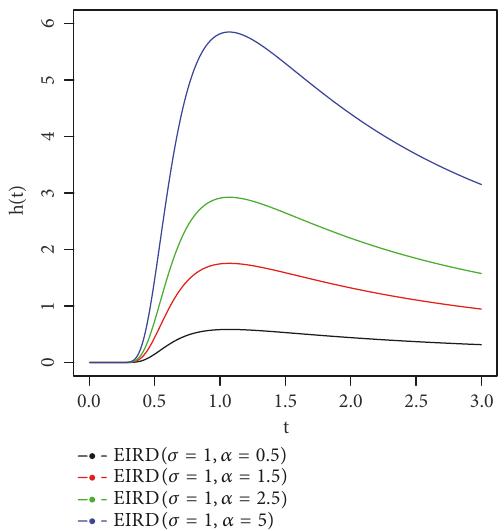
Figure 4: Curve of hazard function of EIRD with different values of shape